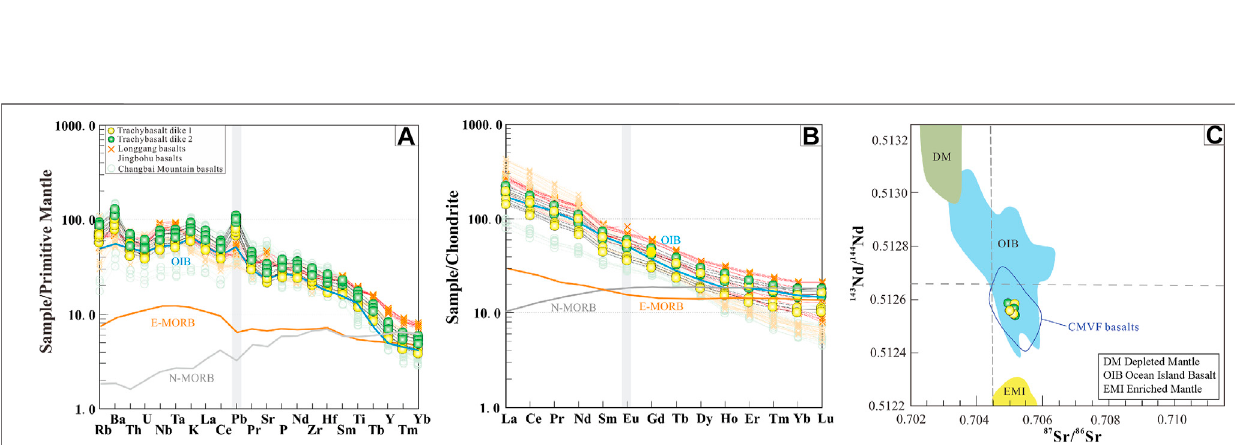
Frontiers in Earth Science |